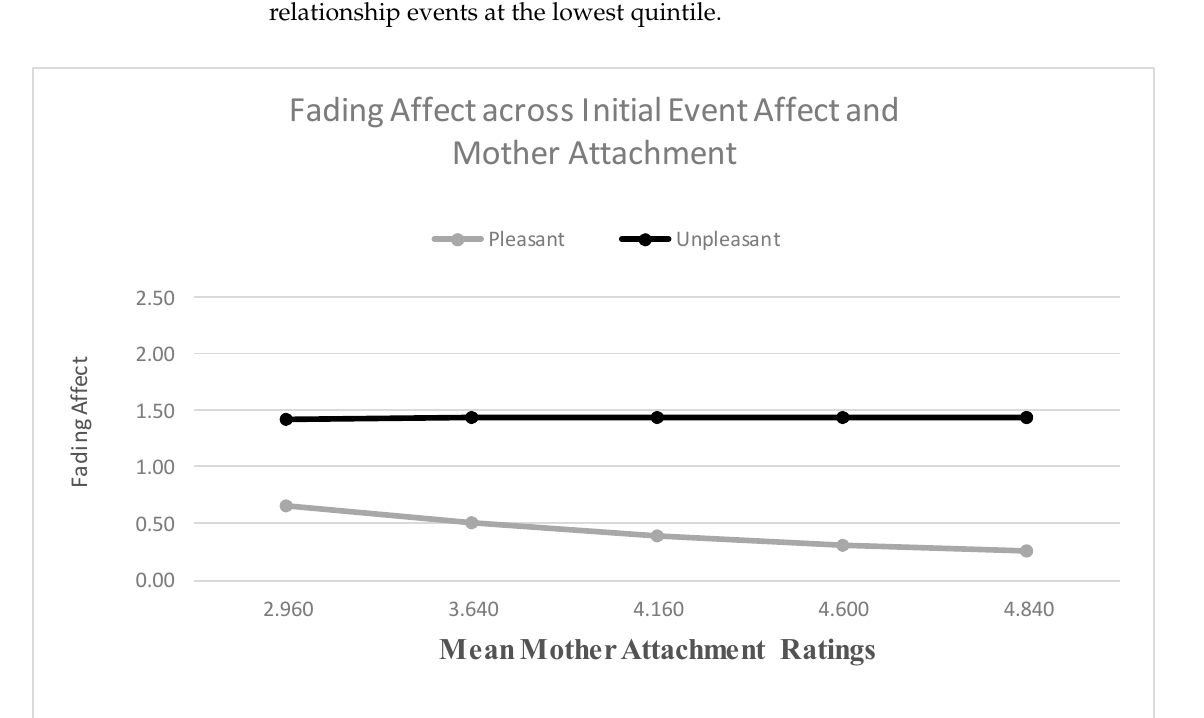
Figure 7. Fading affect for pleasant and unpleasant events across quintile levels (10th through 90th) of mother attachment.